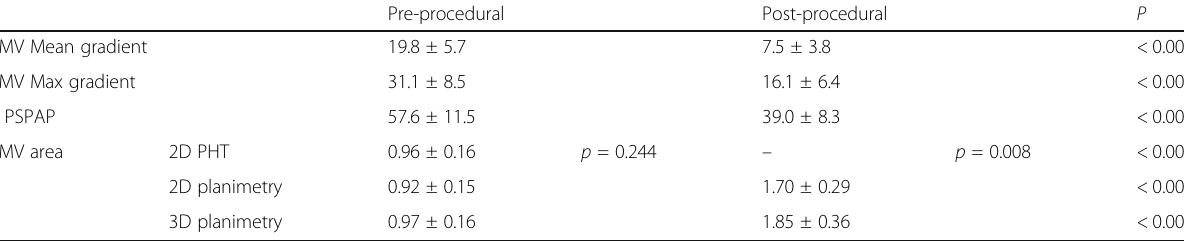
Table 1 Change in MV gradients, PSPAP, and MV area before and after BMV Pre-procedural Post-procedural